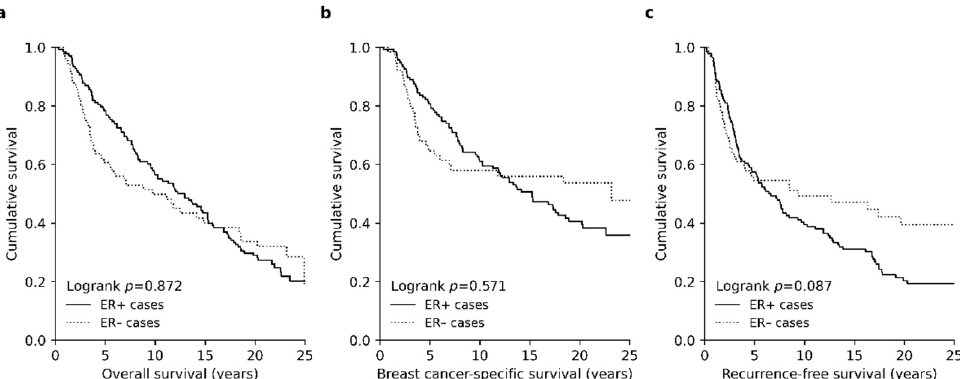
Figure 1. Survival functions in the ER+ and ER − patients. ( a ) ER − BC was associated with poor short-term overall survival and ( b ) breast cancer-specific survival especially during the first five years of follow-up compared to ER+ BC. ( c ) The difference in survival was lifted off over time, mainly due to different recurrence rates on long-term